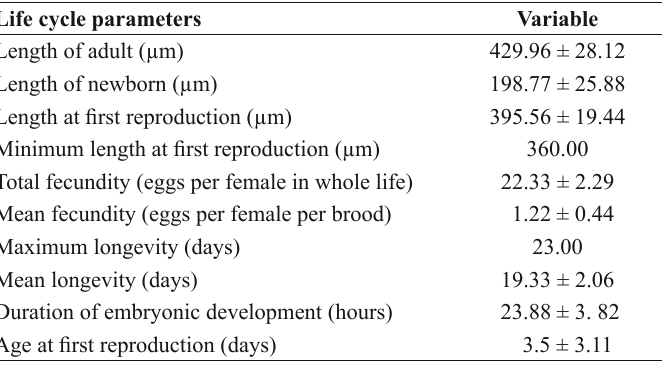
Life-cycle variables (mean ± standard deviation: n = 9) of the rotifer Philodina roseola cultured in the laboratory at 25±1°C, under a photoperiod of 16 h light: 8 h dark, and fed on a suspension of Raphidocelis subcapitata at 10 5 cells mL -1 .